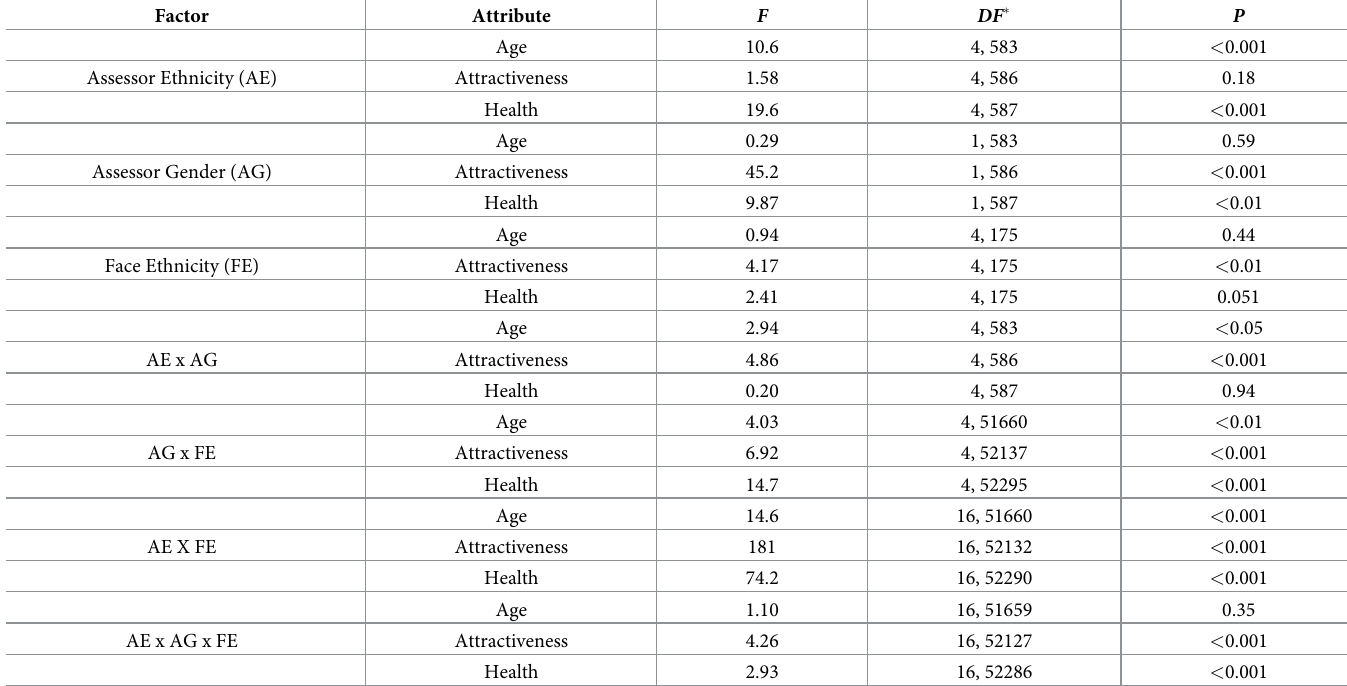
Table 3. Main and interaction effects of assessor ethnicity and gender, and participant (“face”) ethnicity on age, attractiveness, and health assessments. Factor